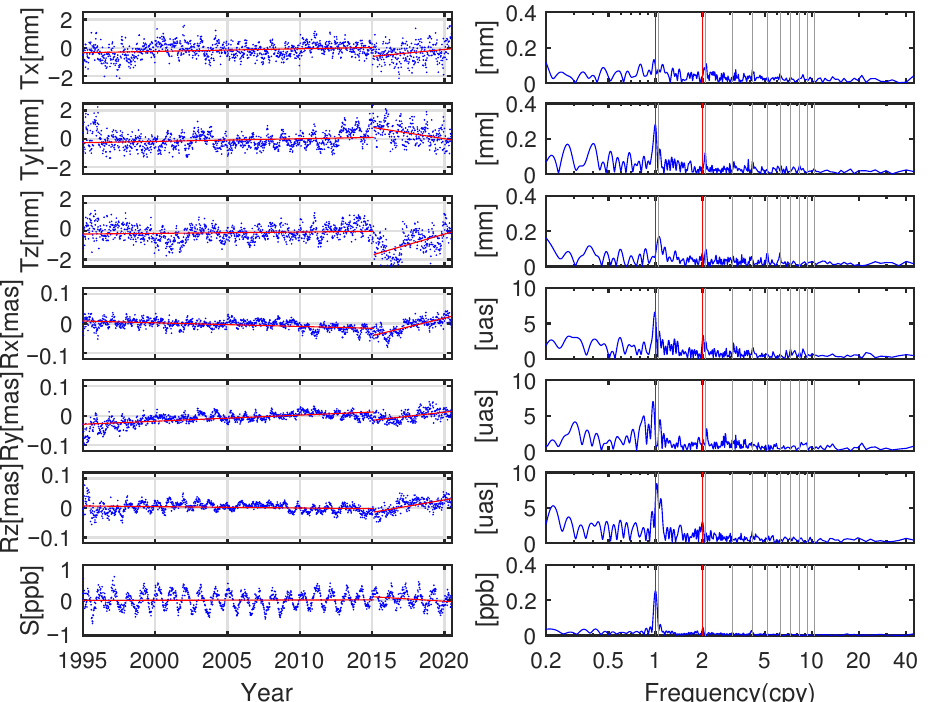
Figure 5. Time series of the translation, rotation, and scale offsets estimated between ITRF2014 and the corrected IGS solutions and their amplitude spectra from top to bottom (blue). The linear trend curves before and after 14 February 2015 of the Helmert parameters are also plotted (red lines). The vertical gray lines indicate the first 10 harmonics of the GPS draconitic year, and the two vertical red lines indicate the annual and semiannual